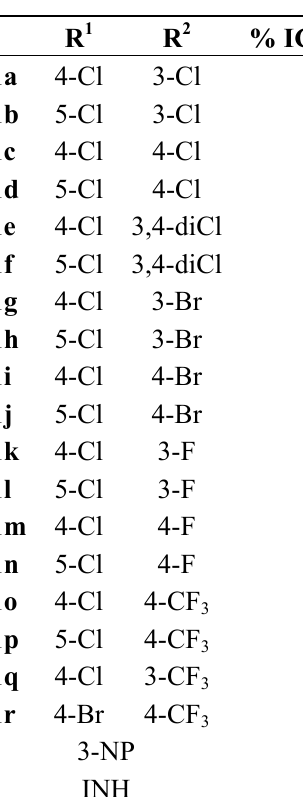
Table 3. ICL inhibition activity of salicylanilide 4-(trifluoromethyl)benzoates 1